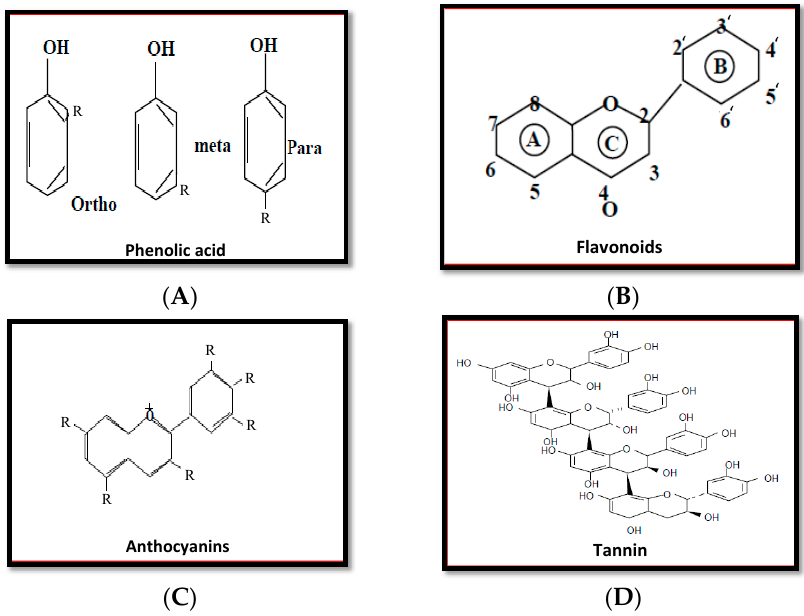
Figure 1. Chemical structure of phenolic acid ( A ), flavonoids ( B ), anthocyanins ( C ), and tannins ( D ).